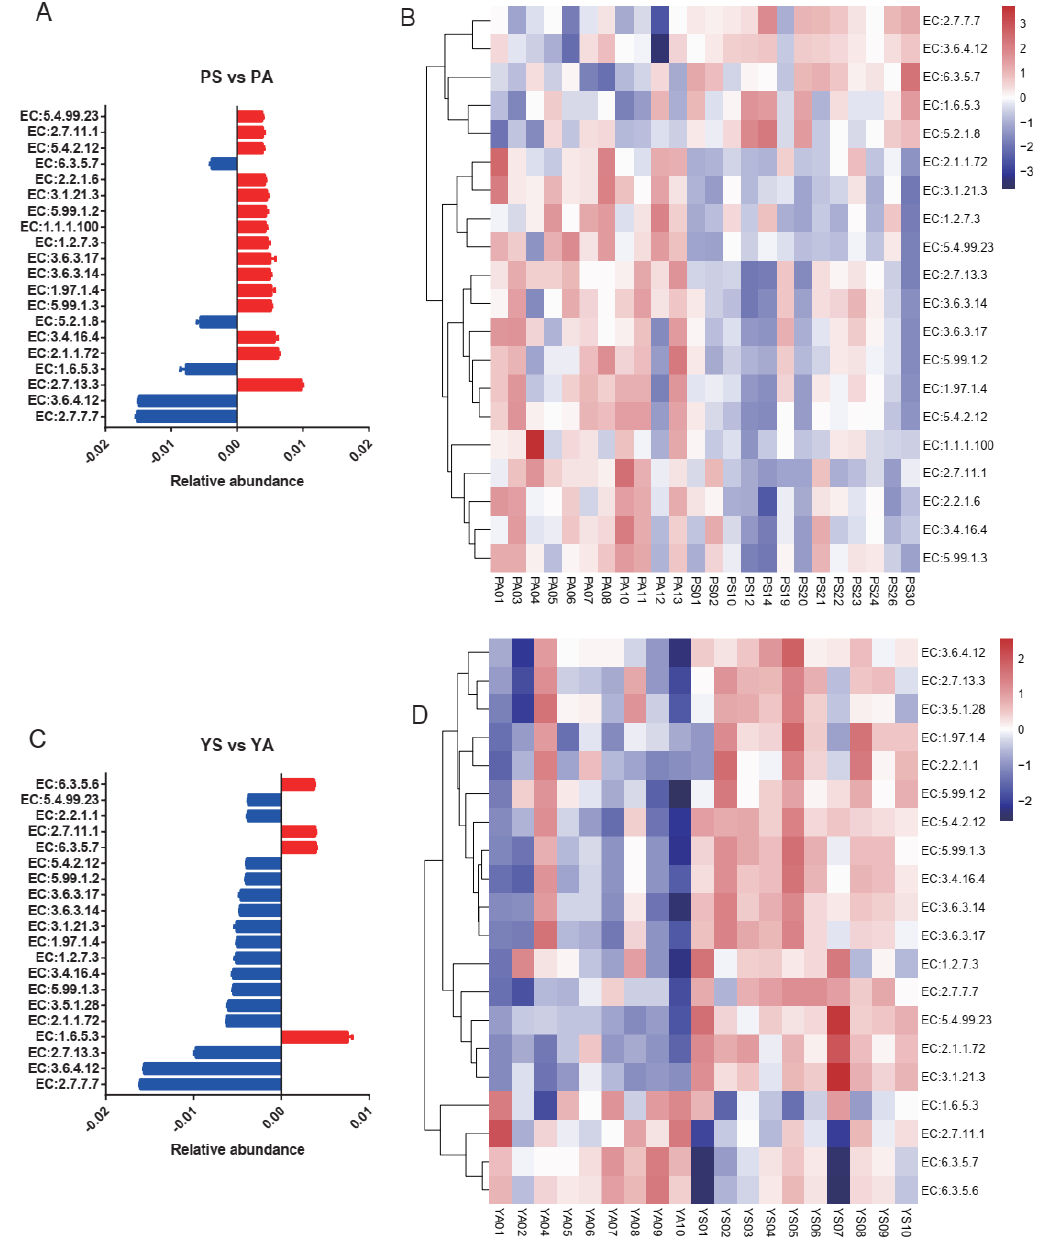
Figure 6. The top 20 enzymes with significant differences between sympatric groups and allopatric groups. The “PA”: the pikas in the allopatric enclosure, “PS”: sympatric pikas with yaks, “YS”: sympatric yaks with pikas, and “YA”: yaks in allopatric farms. ( A , B ) The enzymes with significant differences between sympatric pikas and allopatric pikas. ( C , D ) The enzymes with significant differences between sympatric yaks and allopatric yaks.